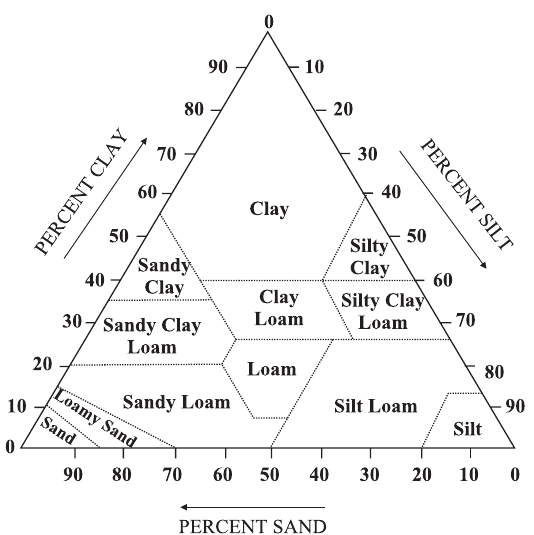
Figure 2. Textural triangle for classification of soil materials according to clay, silt and sand